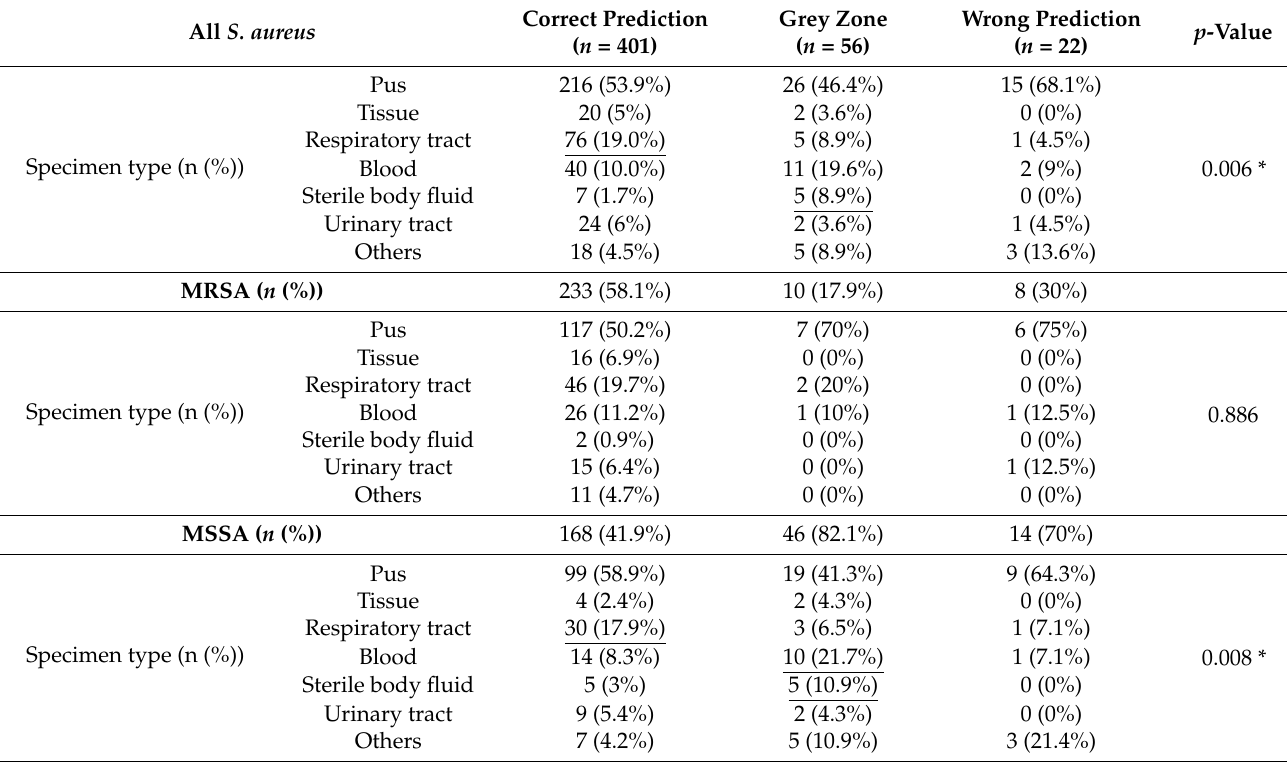
Table 1. Characteristics of the